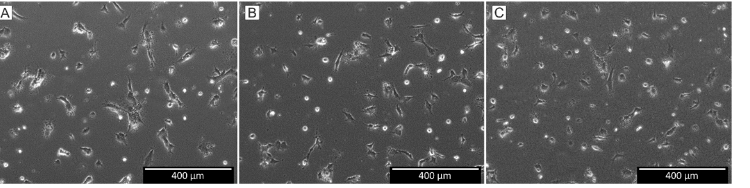
Figure 2. HUVECs seeded in three-dimensional collagen type I gels with different BSP concentrations. ( A )—0 BSP; ( B )—1 µ g/mL BSP; ( C )—5 µ g/mL BSP.